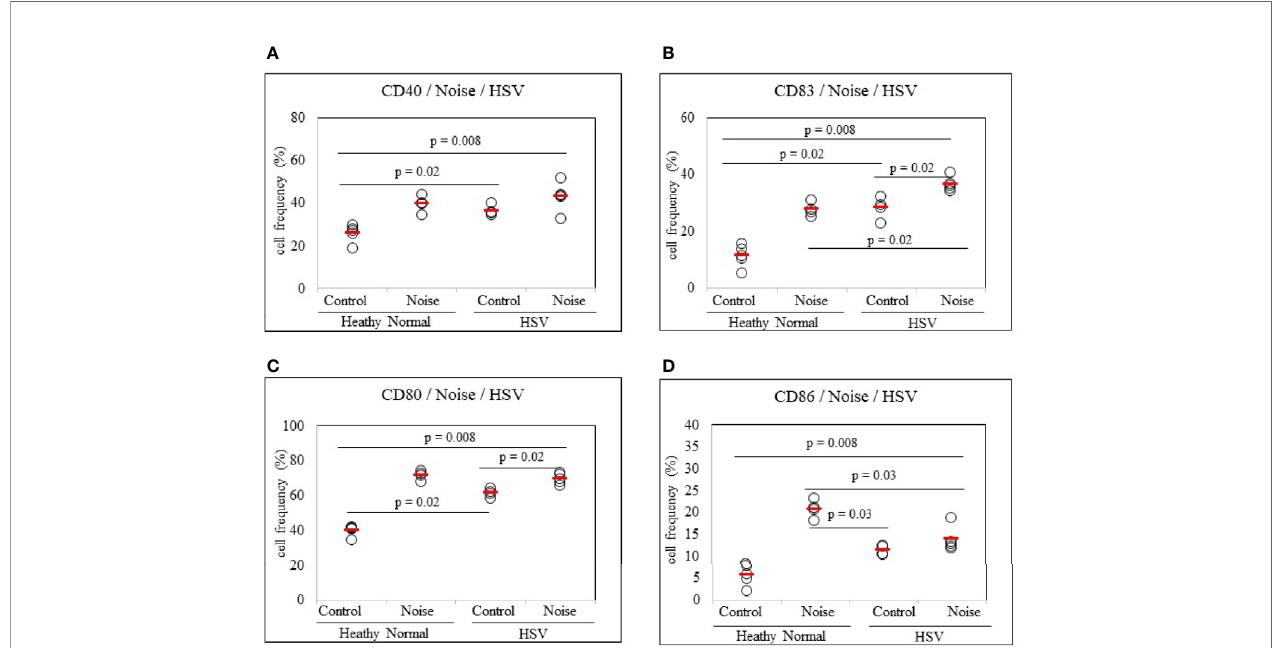
FIGURE 5 | Frequency analysis of DC-stimulating molecules CD40, CD83, CD80 and CD86-expressing cells in normal mice and HSV-1 inoculated mice with or without noise stress. Mice were exposed to noise stress for 10 days after the fi rst HSV-1 inoculation. One day after second inoculation of HSV-1, peripheral blood leukocytes were applied to fl ow cytometry (A – D) . Experiments were conducted independently at least three